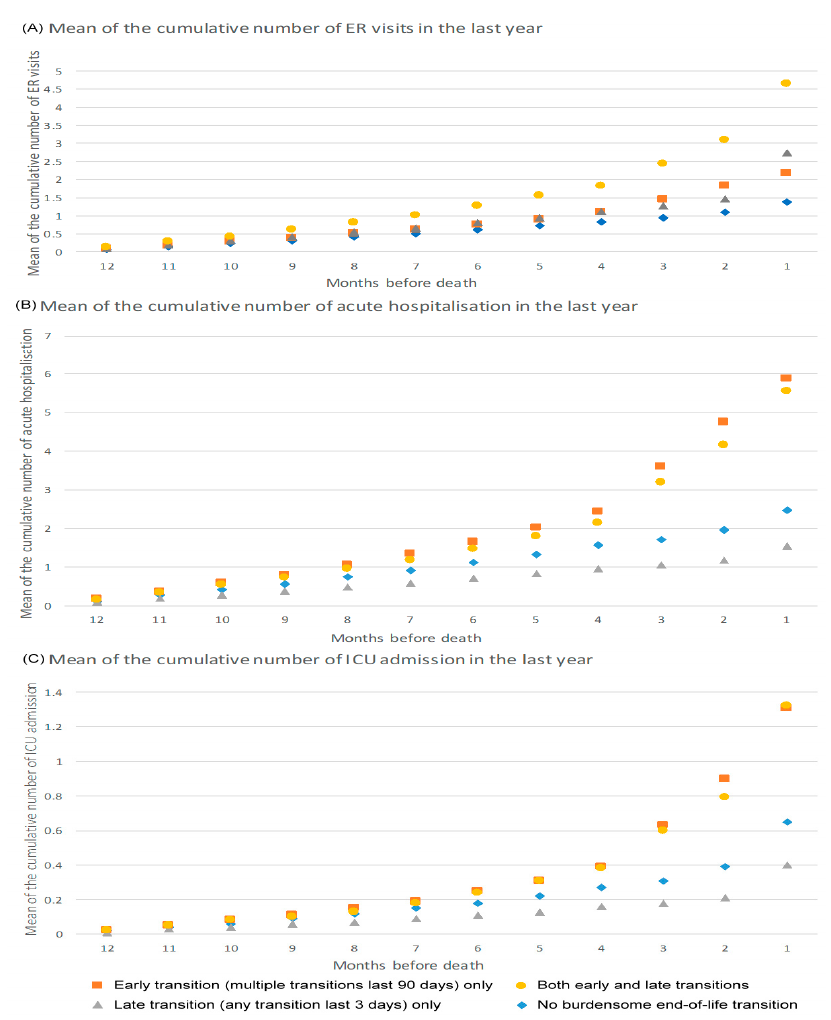
Figure 2. The utilisation of acute healthcare in the last year for people with dementia by type of burdensome end-of-life transition. ER = emergency room and ICU = intensive care unit.